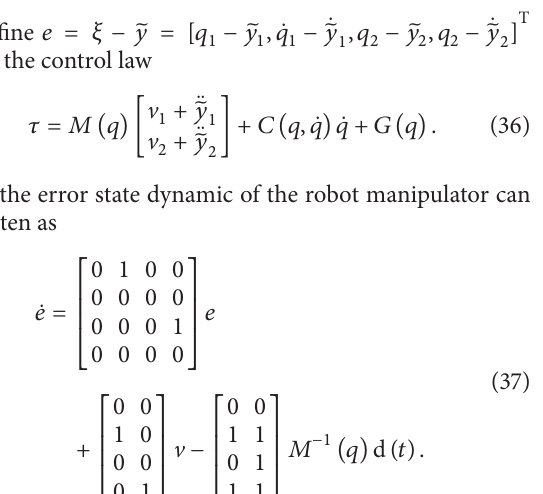
Figure 3: The tracking error 𝑒 2 (𝑡) of velocity ̇𝑞 1 for link